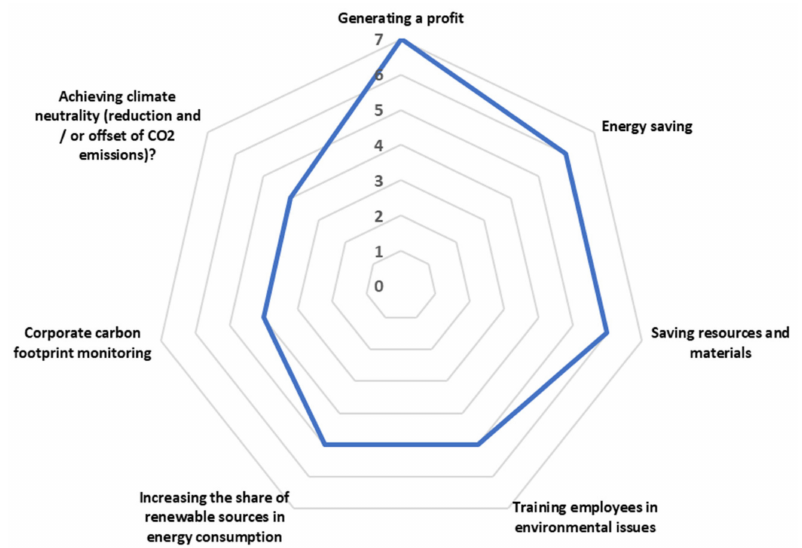
Figure 2. Assessment of importance for the organization of the indicated goals (1–completely unimportant, 7–very